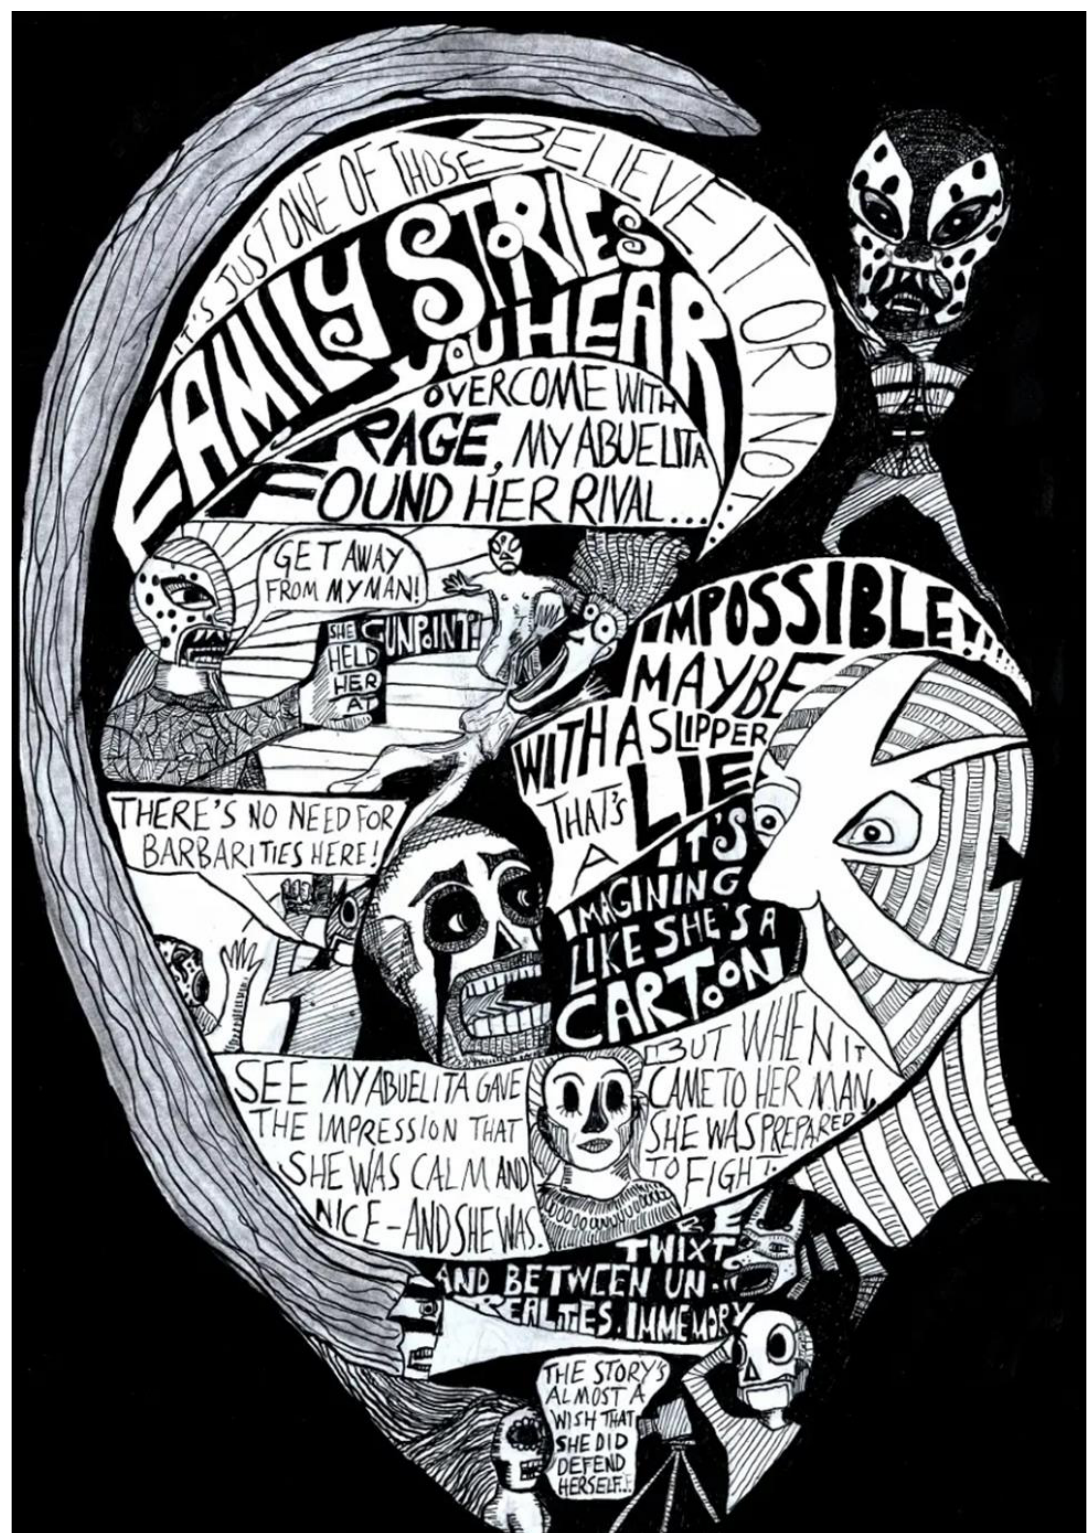
Figure 11 : It’s just one of those family stories yo u hear (Sherwood Gonzalez 2019,